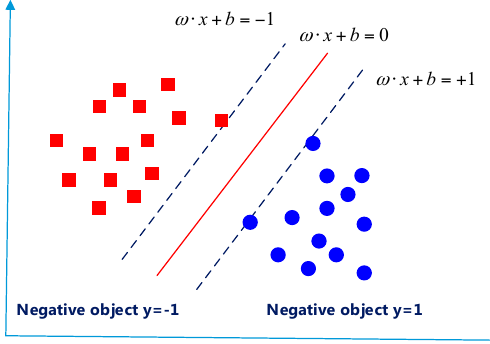
Figure 10. Support vector machine (SVM) classifier.